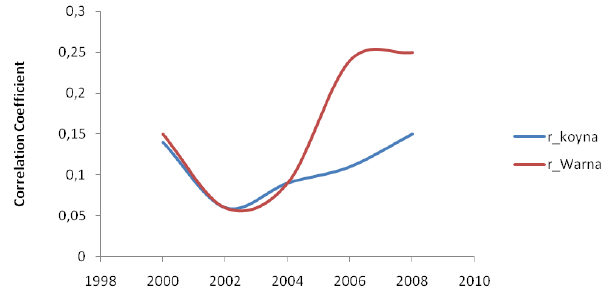
Fig. 7. The maximum correlation coefficients for Koyna and Warna at different time Fig 7. The maximum correlation coefficients for Koyna and Warna at different timeperiods. Table 1 . The correlation coefficient, time lag (for Koyna reservoir and Warna reservoirwith the seismicity of the region). Year Koyna- coef. Lag Warna- coef.